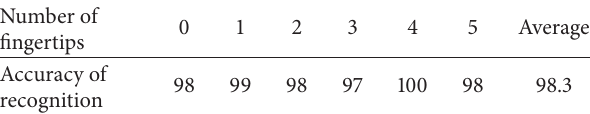
Table 2: Accuracy of fingertip